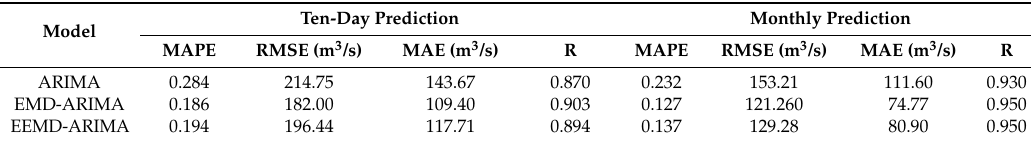
Table 1. Statistical results of the predictive accuracy.